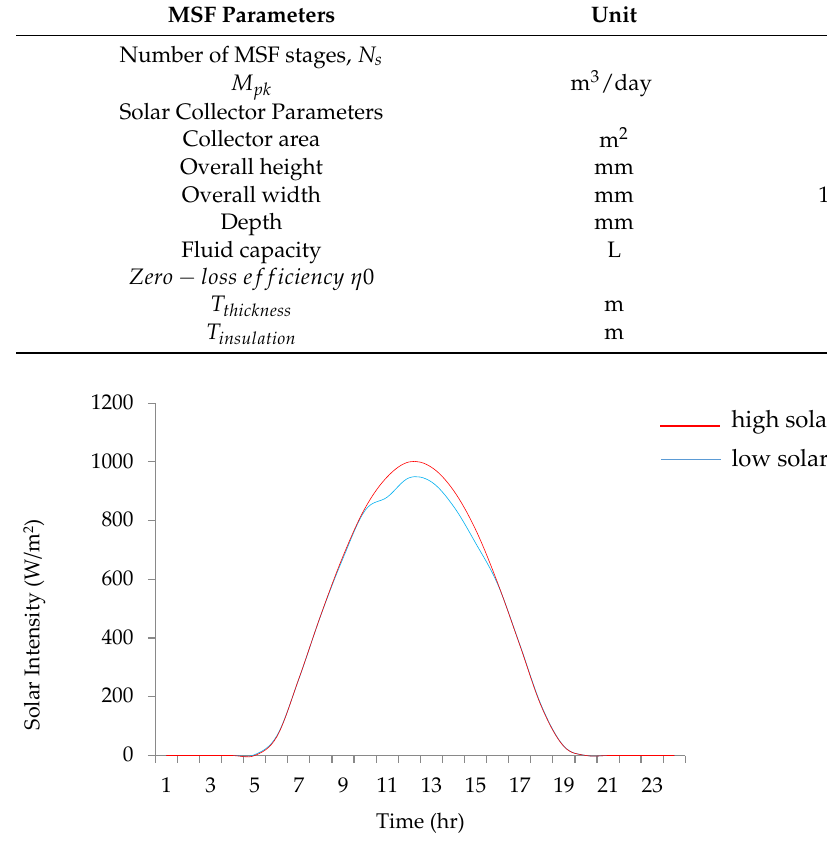
Table 3. System technical specifications and operation data used for the experiment.